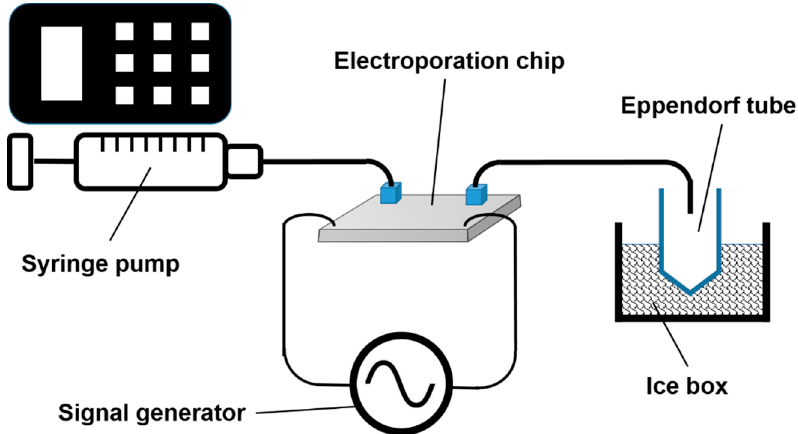
Figure 5. Schematic drawing of the measurement setup. For the sake of clarity, the analog circuit board, as well as the two oscilloscopes, are not shown. Drawing is not to scale.